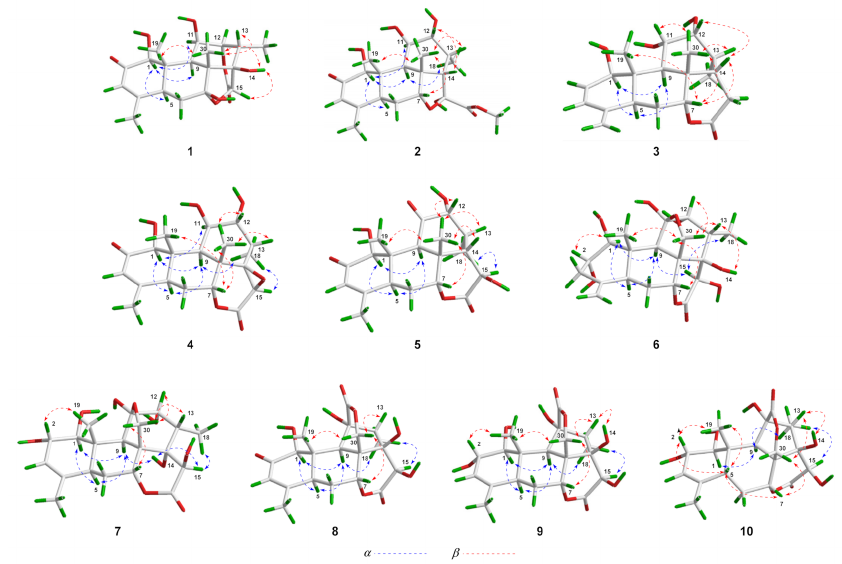
Figure 3. Key NOESY correlations of compounds 1 – 10 .